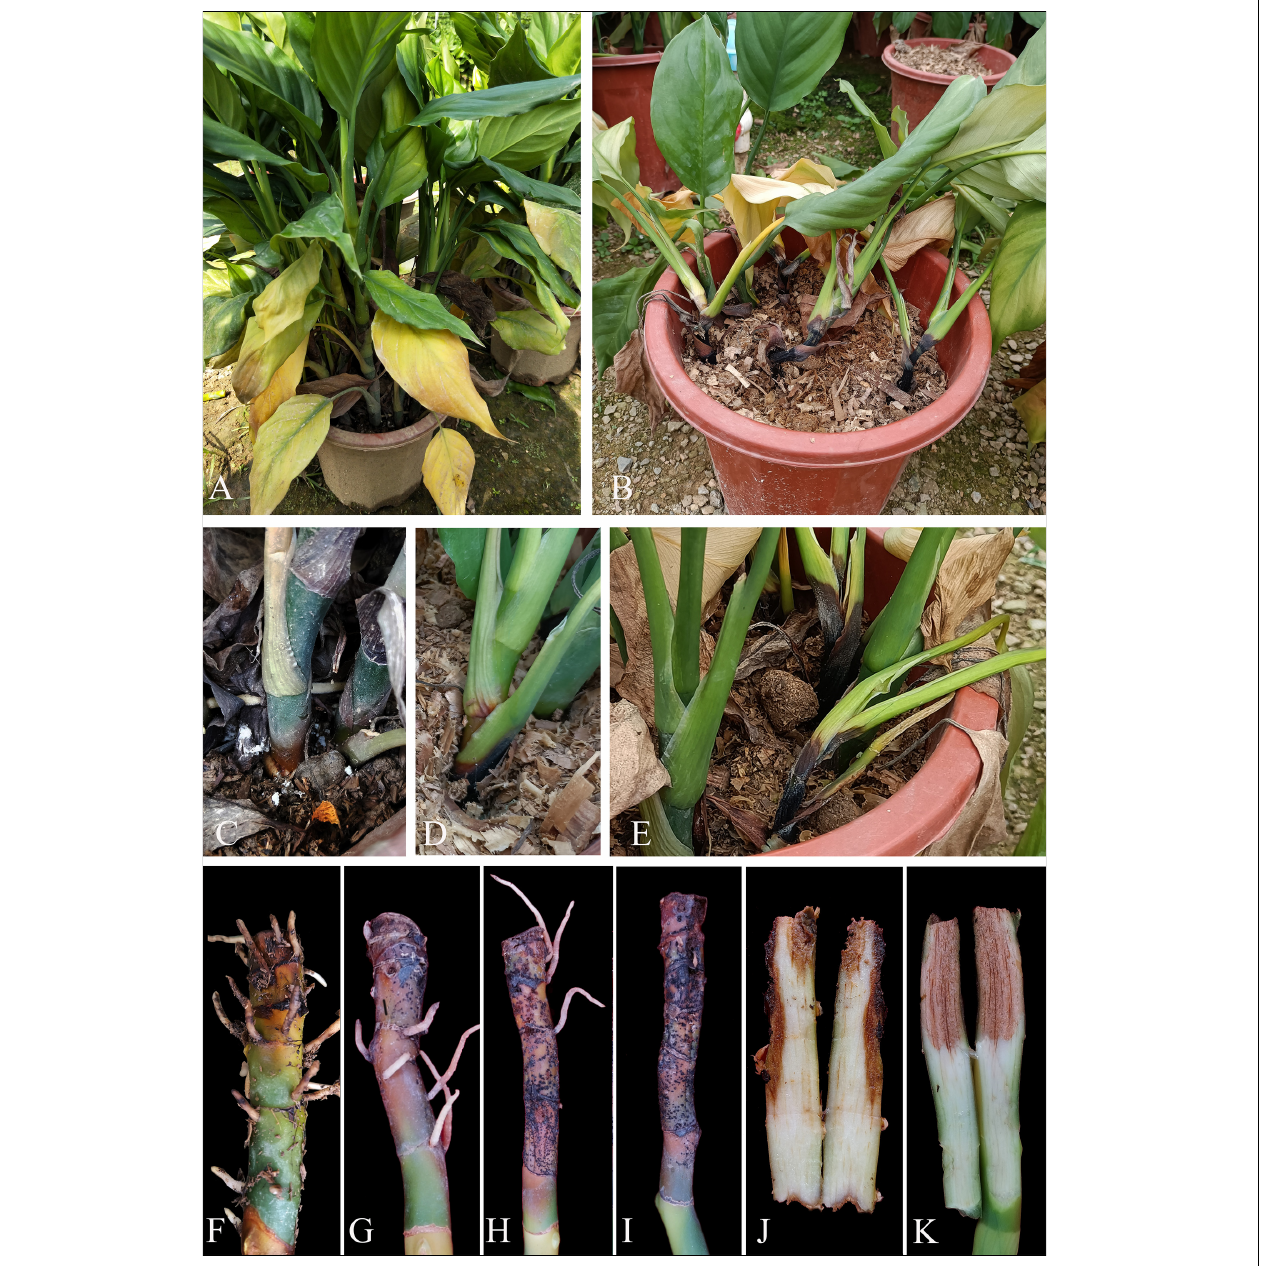
FIGURE 1 | Field symptoms of stem root rot on Aglaonema modestum . (A,B) Symptoms of whole plants. (C–E) Stem rot on potted plants. (F–I) Progressive stem rot. (J,K) Internal symptoms of stem rot.